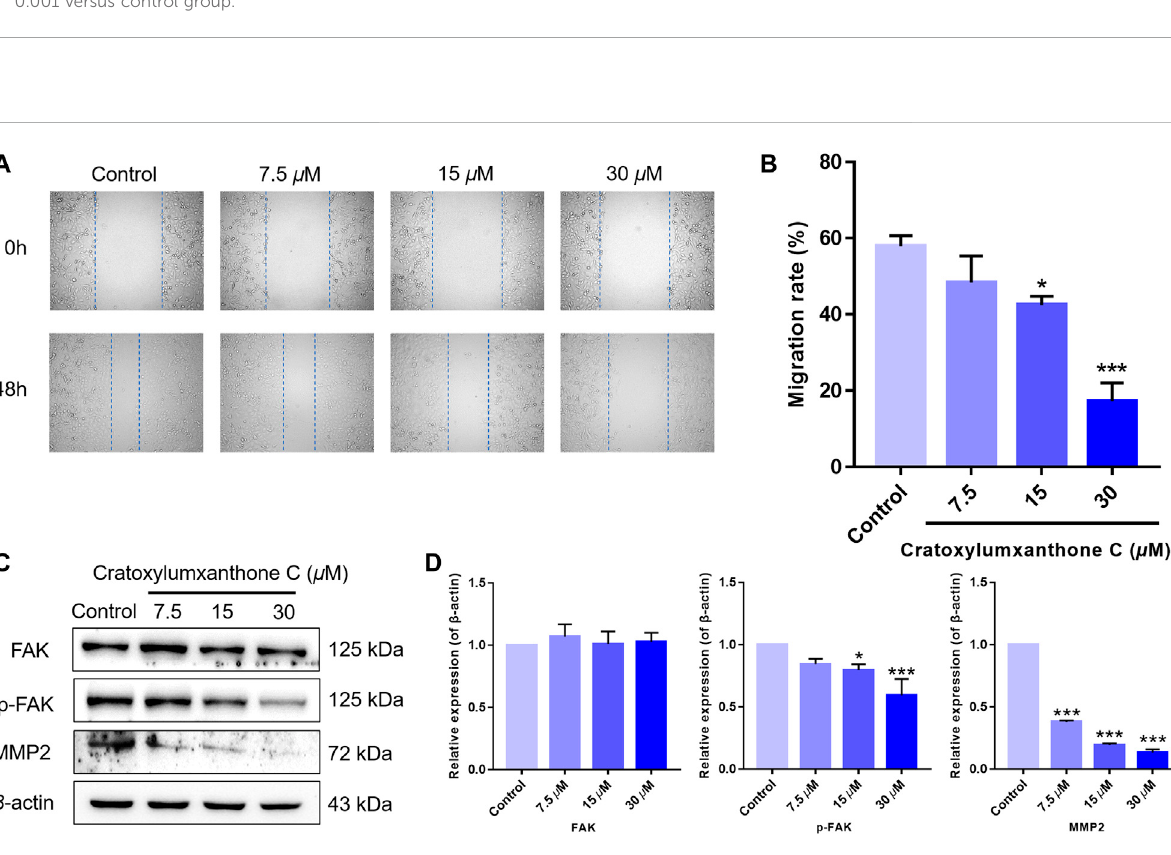
FIGURE 7 Cratoxylumxanthone C inhibited migration in A549 cells and regulated FAK/MMP2 signaling pathway. (A) A549 cells were photographed at 0 and 48 h. (B) Data of migration rates (%) were shown in the histogram. (C) Western blotting analysis was used to evaluate the effects of cratoxylumxanthone C on the expression of FAK, p-FAK, MMP2. (D) Histogram of the protein relative expression level compared with control group. The results are expressed as means ± SD. * p < 0.05 and *** p < 0.001 versus the control